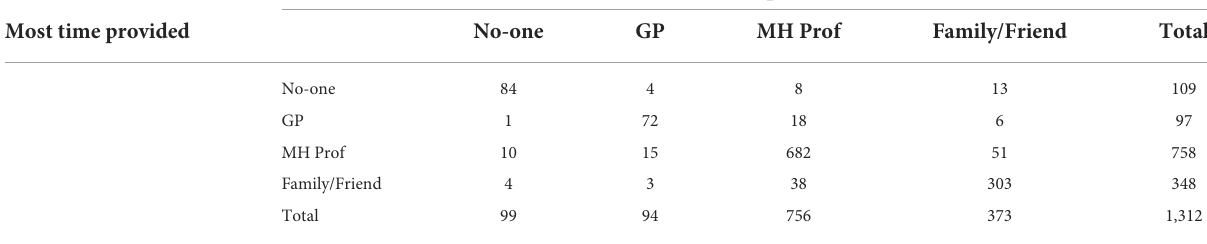
TABLE 3 Relationship between supporter time and supporter helpfulness as perceived by